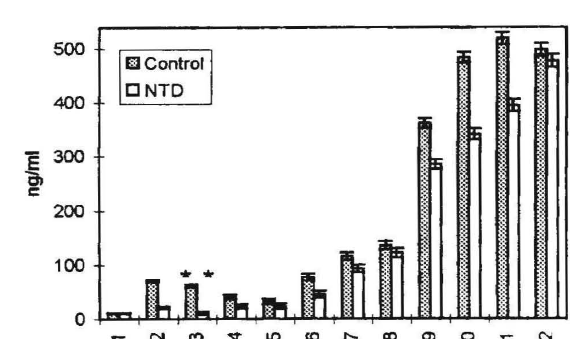
Figure 1. Blood folate/B vitamin status 1 : plasma 5CH,H .PteGlu" 2 : Total whole blood 5CH H,PteGlu" 3 : Intraerythrocyte 5CH,H.PteGlu total· plasma 5CH,H.PteGlu.), 4: 5CH,H.PteGlu;, 5: 5CH H.PteGlu" 6 : 5CH,H .PteGlu" 7 : 5CH,H. PteGh, 8 : 5C,H,PteGlu., 9 : Methylfolates retained by the cell (5CH,H .PteGlu, .... 5 •• ), 10: Total whole blood 5CH,H, PteGlu".2 ..... , .• ) 11 : Serum B12*, 12: Red blood cell folate * . Notes: *obtained using radiometric binding assay, 5 CH,H.PteGlu=5methyltetrahydropteroy Imonoglutamate. Subscript value denotes number of glutamate residues conjugated to the folate molecule.